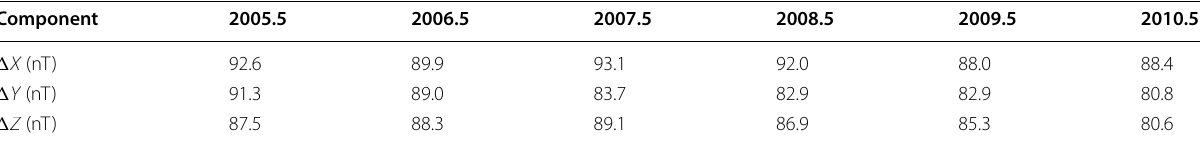
These differences were computed using 684 data points over the modelled area Table 4 RMS values of the differences between SACFM-2 and CHAOS-6 secular variation models between 2005 and 2010 at 0.8 km altitude